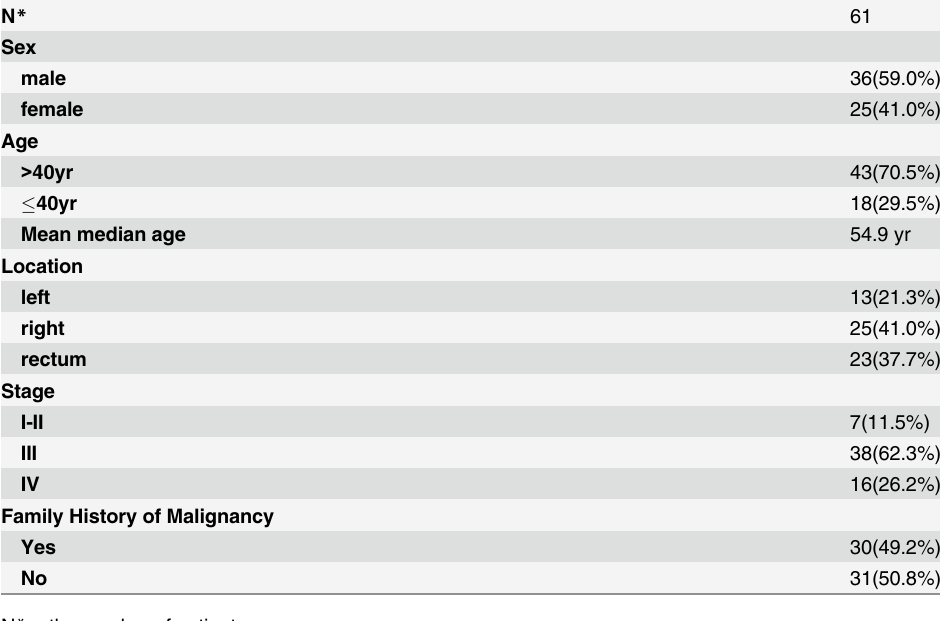
Table 1. Clinicopathologic features of colorectal adenocarcinoma with signet-ring cell